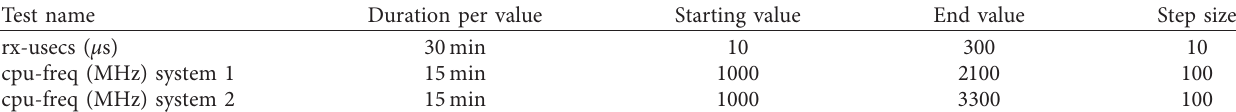
Table 3: CPU frequency and interrupt coalescing test parameters.